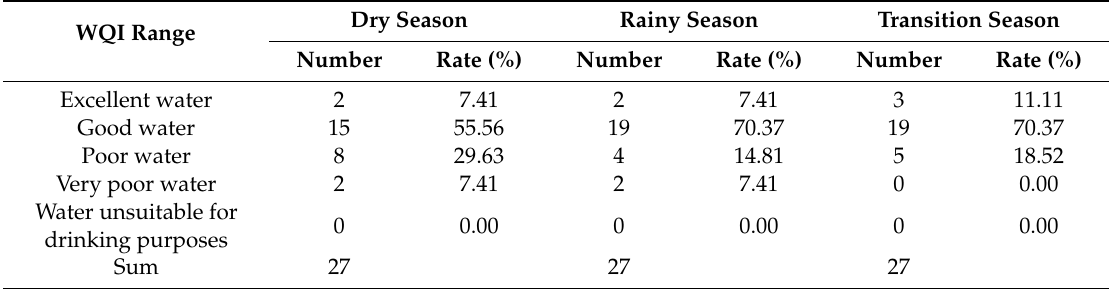
Table 2. Statistics of water quality index classification for di ff erent seasons in the Hutuo River alluvial-pluvial fan. Dry Season Rainy Season Transition Season WQI Range Number Rate (%) Number Rate (%) Number Rate (%) Excellent water 2 7.41 2 7.41 11.11 Good water 15 55.56 19 70.37 Poor water Very poor water 0.00 Water unsuitable for 0 0.00 0 0.00 0 0.00 drinking purposes Sum 27 27 27 Note: WQI: water quality